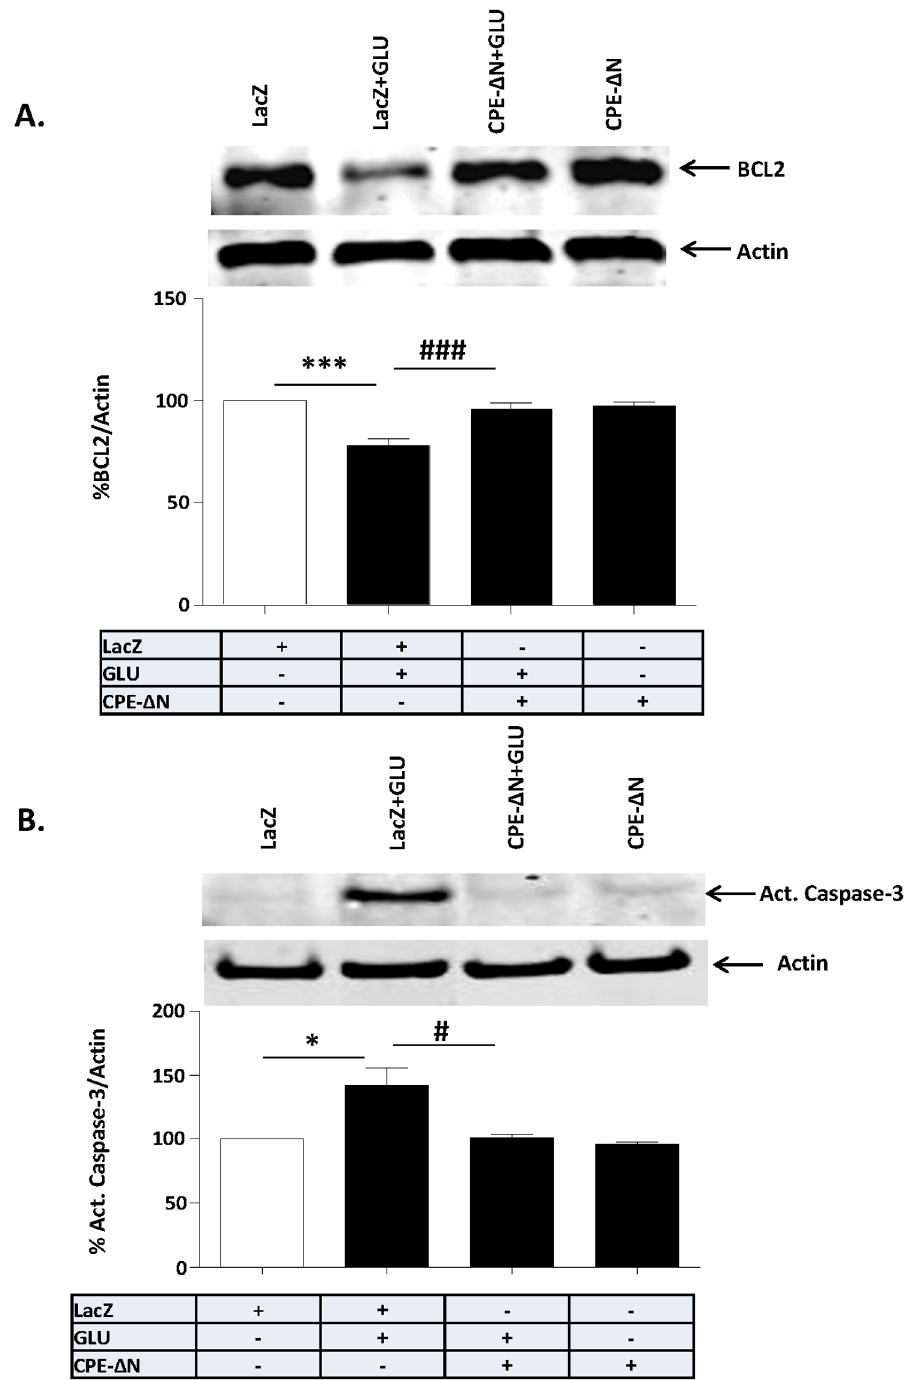
Figure 6. Neuroprotection by CPE- D N involves BCL-2 and Caspase-3. In A, B, rat primary cortical neurons were transduced with CPE- D N or LacZ viral vectors and subsequently treated with or without with glutamate for 24 h. A. Top panel: Western blot of BCL-2 protein in primary cortical neurons challenged or not with glutamate. Actin was also analyzed and served as an internal control for protein load; bottom panel: Bar graphs showing the quantification of BCL-2 normalized to actin and expressed as a % compared to vehicle treated control cells. Note that CPE- D N significantly inhibited the glutamate-induced decrease in